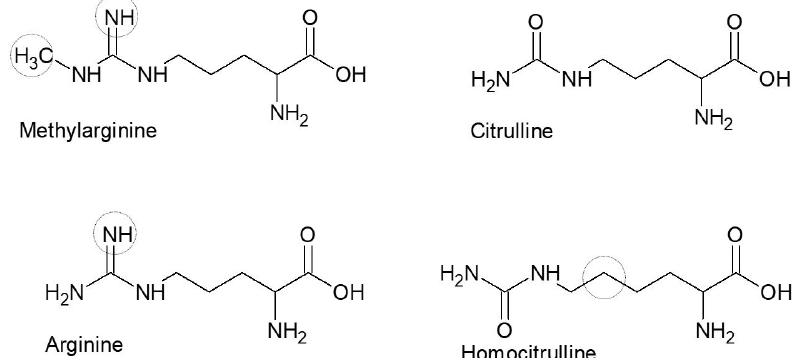
Figure 1. Schematic illustration of the central amino acid substitutions found in the peptides used in this study. The point of origin is citrulline; the circles represent atoms di ff erent from citrulline.